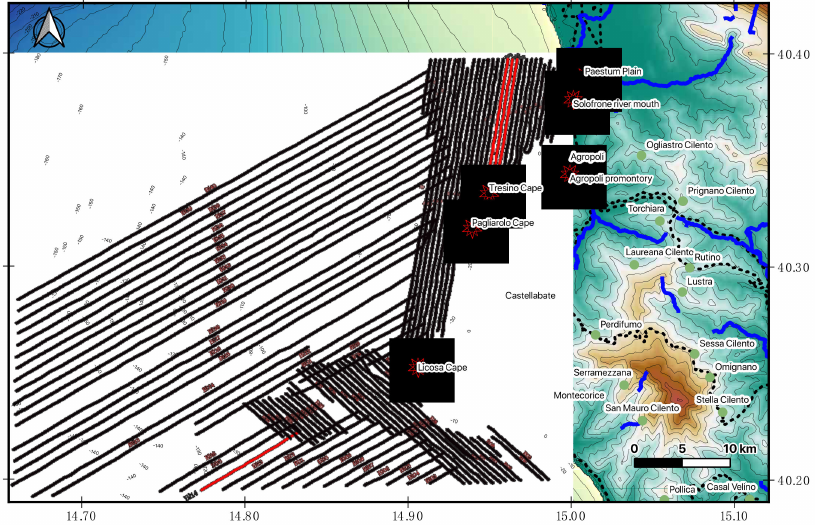
Figure 3. Location map of sub-bottom Chirp profiles superimposed to onshore–offshore DEM of the Cilento Promontory. Red lines indicate the seismic profiles shown in the